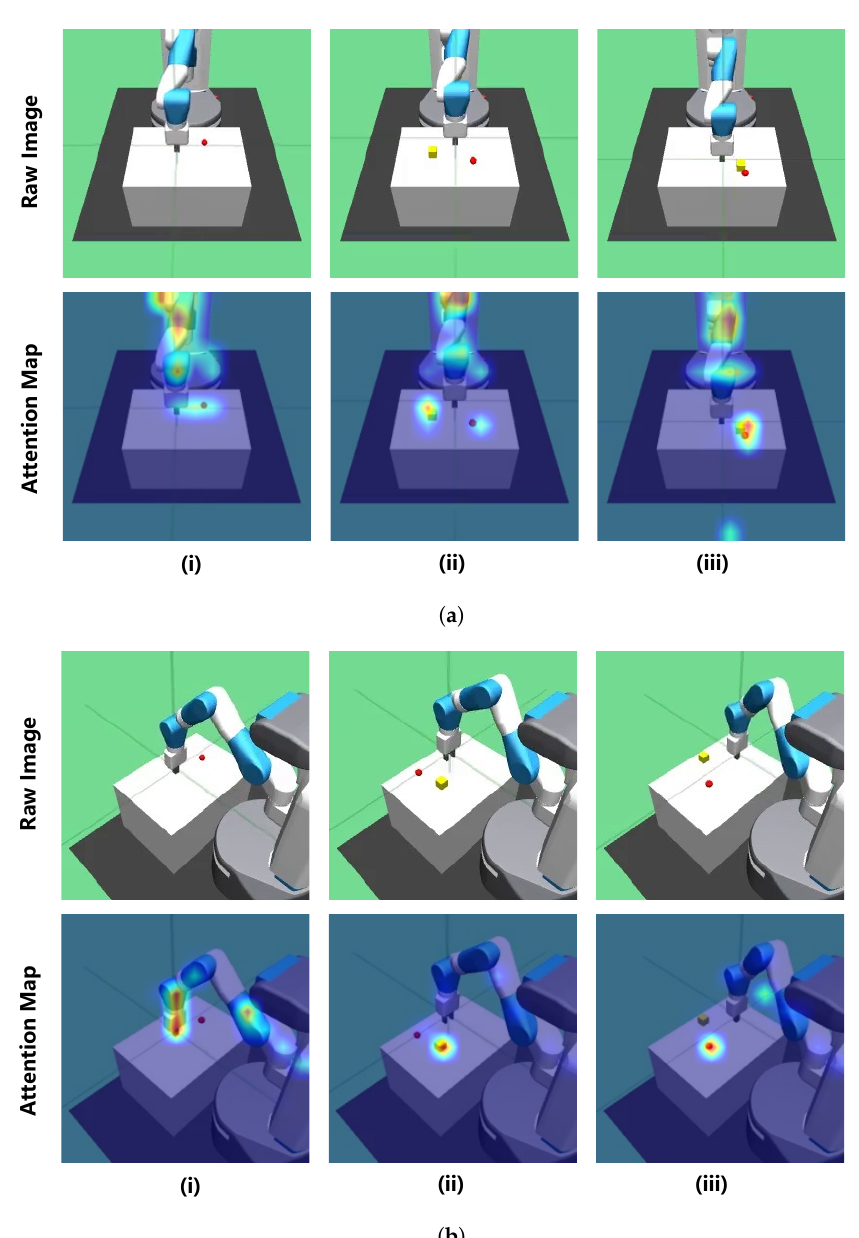
Figure 7. Attention maps. The visualization of attention maps from the Transformer encoder. For each subgraph, each column demonstrates task category: (i) Reach, (ii) Pick-and-Place, and (iii) Push, respectively. The upper row exhibits the raw image of a specific view, and the lower row exhibits the corresponding attention maps. ( a ) comparison of master views; ( b ) comparison of OTS